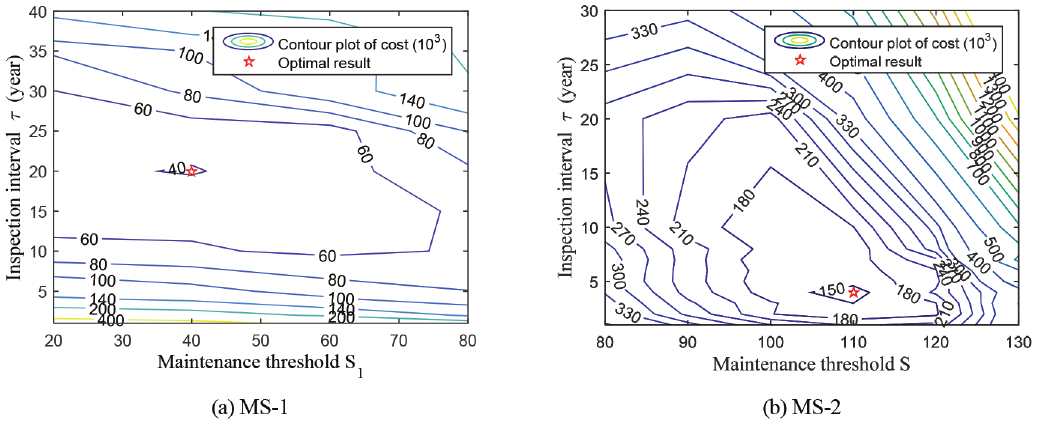
Figure 8. Comparison of maintenance costs by contour plot